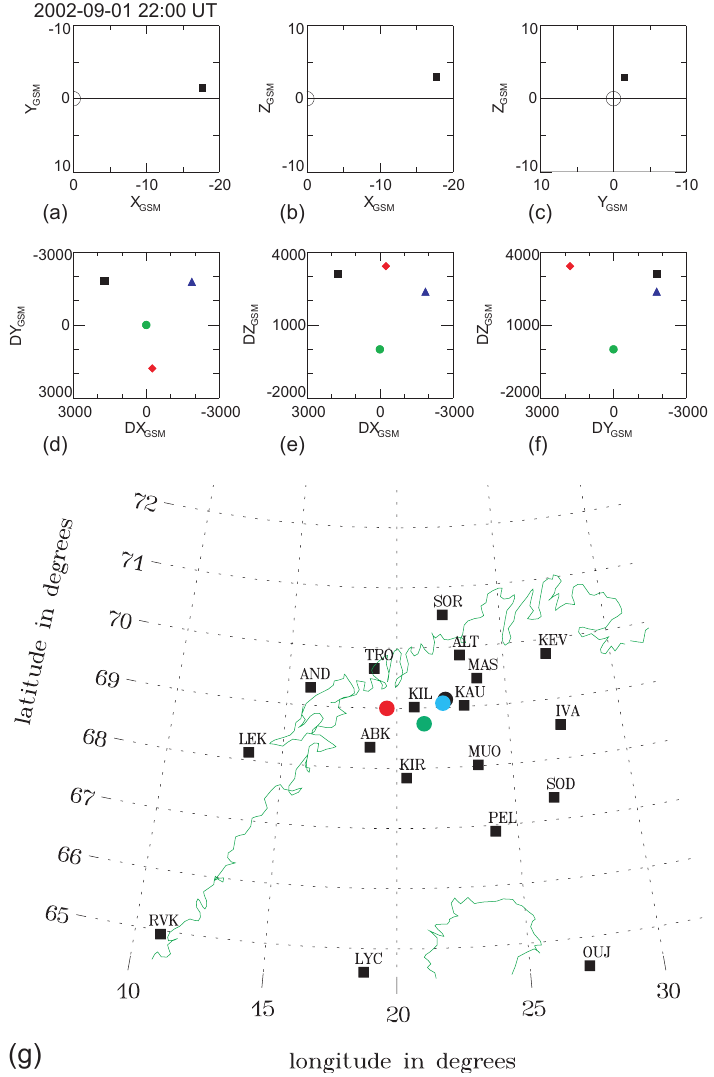
Fig. 1. Location of the four Cluster spacecraft in ( a ) X − Y plane and ( b ) X − Z , plane and ( c ) Y − Z plane, and location relative to the reference spacecraft (Cl 3) in ( d ) X − Y plane and ( e ) X − Z , plane and ( f ) Y − Z plane in the GSM coordinates. ( g ) Location of the MIRACLE stations and that of the Cluster footpoints in geographic coordinates. Clusters 1, 2, 3 and 4 data are indicated with black, red, green, and blue,